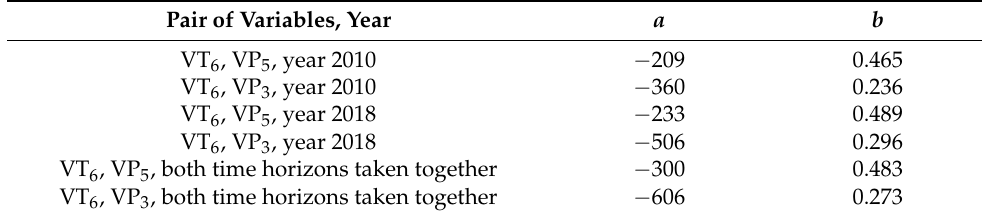
Table 12. Parameters of the investigated model for the Wrocław